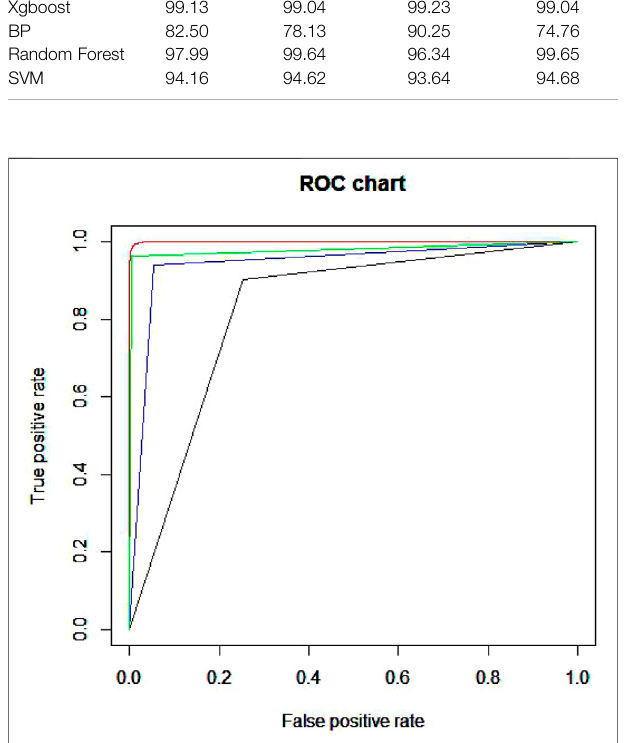
FIGURE 3 | ROC curve of four methods.